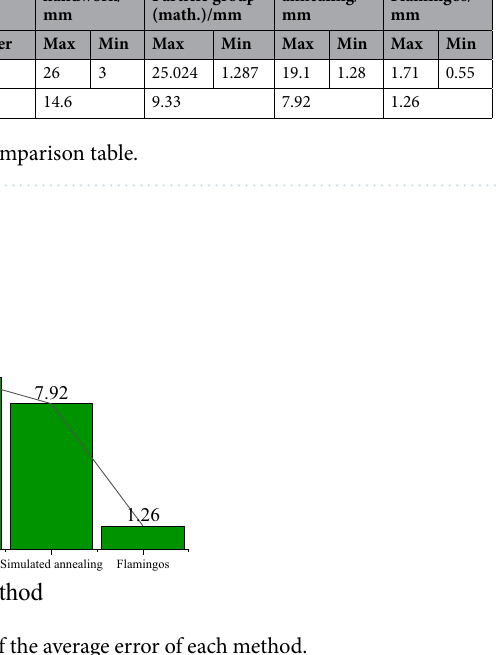
Figure 12. Comparison of the average error of each